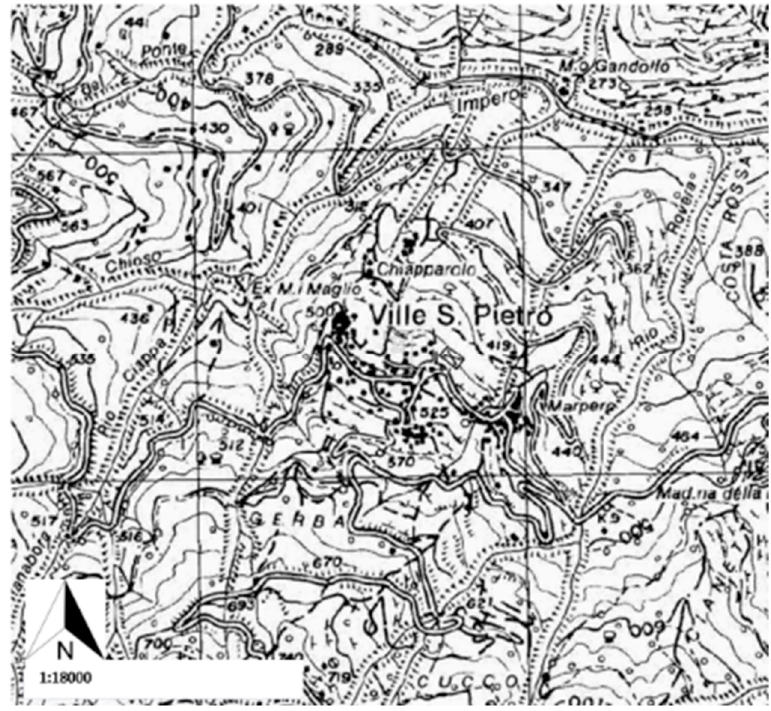
Figure 1. Ville San Pietro (Liguria, Italy).